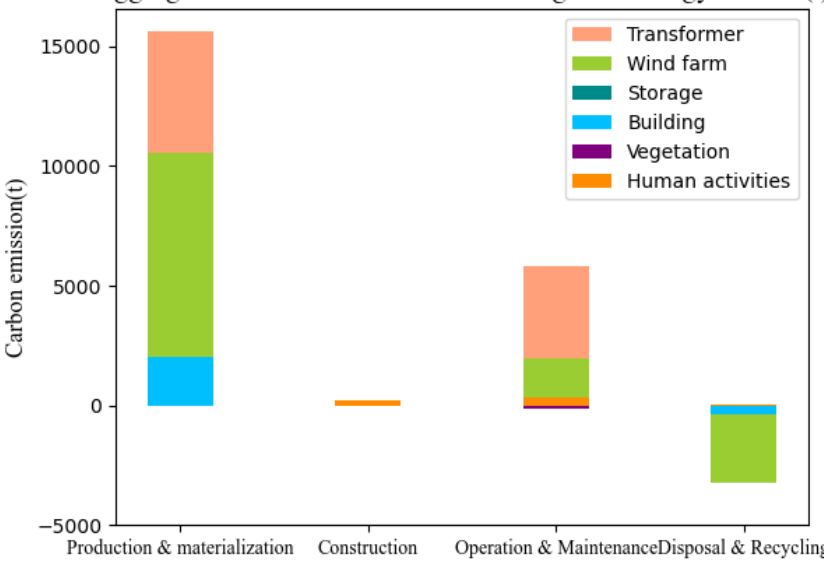
Figure 5. Carbon emissions of each phase in the IES.